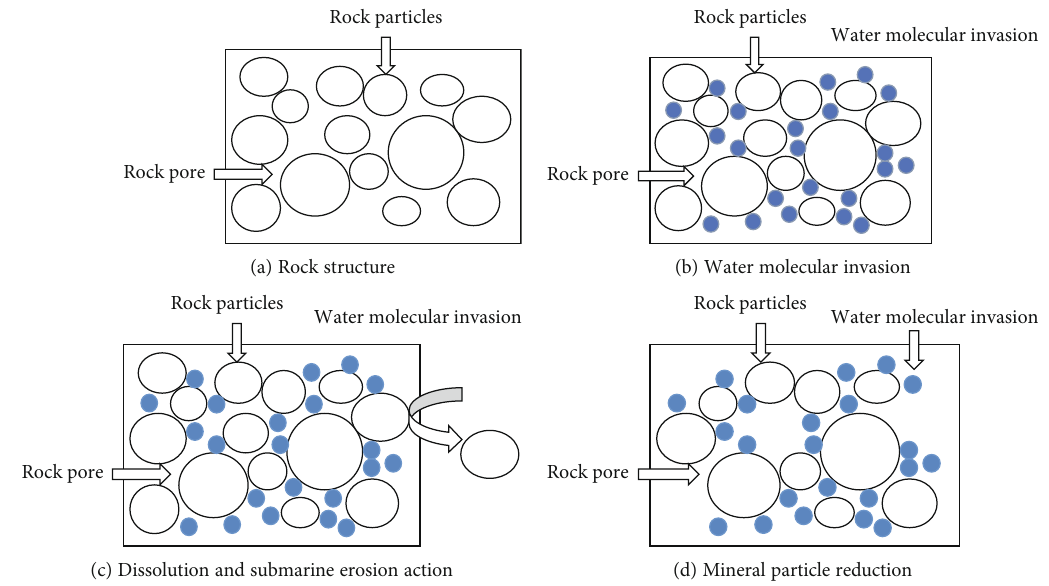
Figure 7: Failure mechanism